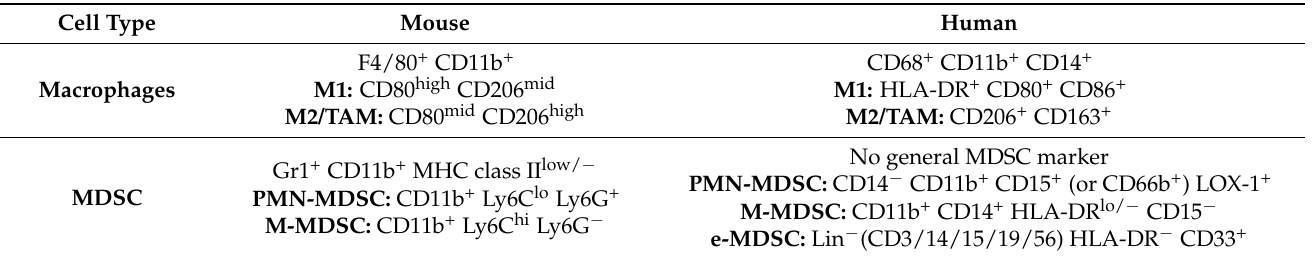
Table 1. Subsets of myeloid cells in mouse and human. Table shows minimal markers for the phenotyping of subsets in macrophages and MDSC in mouse and